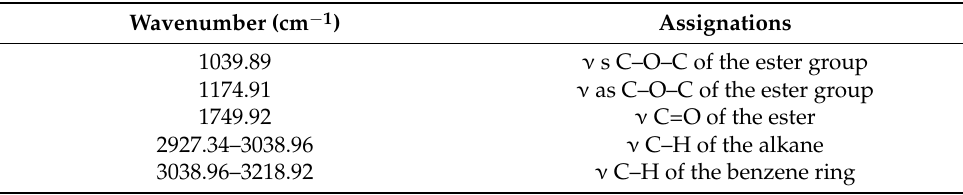
Figure 5. Molecular vibrational spectrums and bond length: ( a ) SBS IR, resin IR, SBS–resin IR; ( b ) C–H bond length of resin. Table 4. Assignations of the bands of the resin molecule vibration